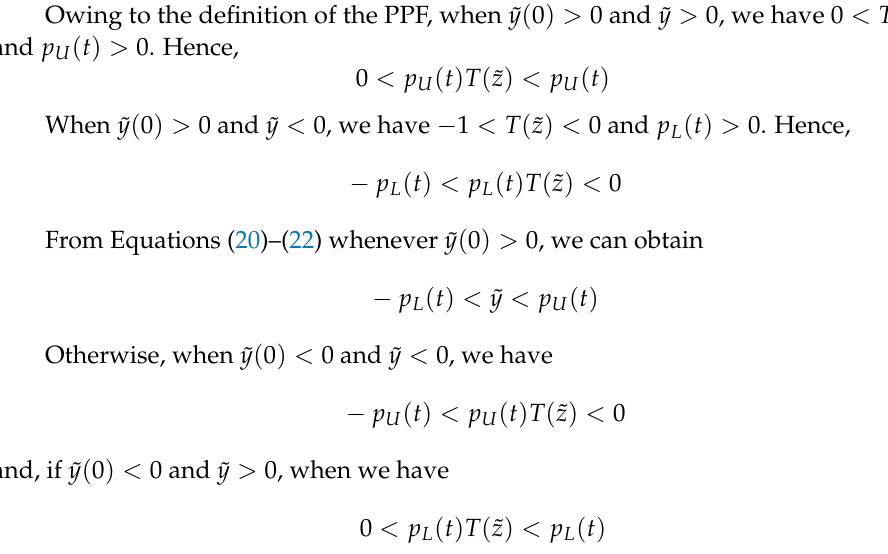
Figure 2. The prescribed tracking error behavior